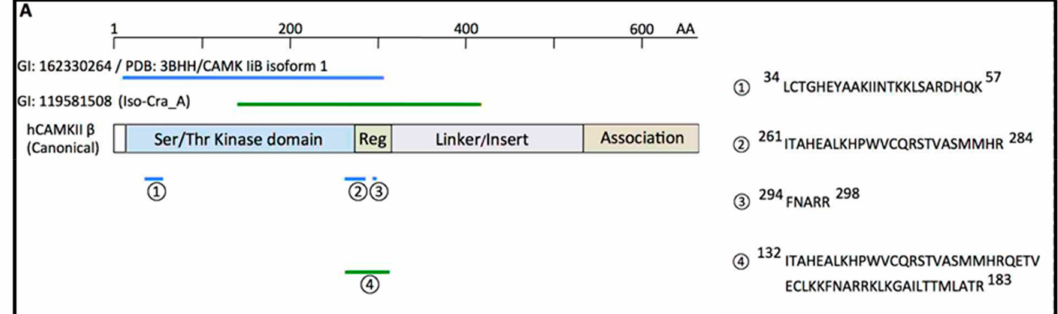
Figure 2. Identification of Ca 2 + -calmodulin-dependent protein kinase II (CAMKII β ) as the human CD38 (hCD38)-associated protein by MALDI-TOF. The domain structures of the canonical sequence of human CAMKII β (isoform-4: UniProtKB / Swiss-Prot, Q13554) are shown as squares in the middle. The kinase domain (14–272) is shown in blue. The regulatory tail (273–315), linker region / insertions, and the association domain (532–664) are also depicted. The corresponding portions of “Chain A, crystal structure of CAMKII β isoform 1” (CAMK IiB isoform 1) and isoform CRA_A are marked as blue and green bars, respectively. The numbers 1–3 and 4 indicate the domains of CAMKII β at which CD38 binds, and sequences of four tryptic peptides of CAMKII β identified by MALDI-TOF / MS, respectively. Pharmacological methods confirmed the functional interaction of CAMKII β and CD38 [56]. Briefly, in human influenza hemagglutinin ( HA)-CD38 complementary DNA (cDNA)-transfected human embryonic kidney (HEK) culture cells, the wound open space surrounded with a healing border became small after 24 h. The transfected cells treated with an inhibitor of CAMKII, KN-62, did not close the open space without wound healing (Figure 3). Quantitatively, CD38 cDNA-transfected samples treated with KN-62 had significantly less migratory activity compared with those without KN, suggesting a possible interaction between CD38 and